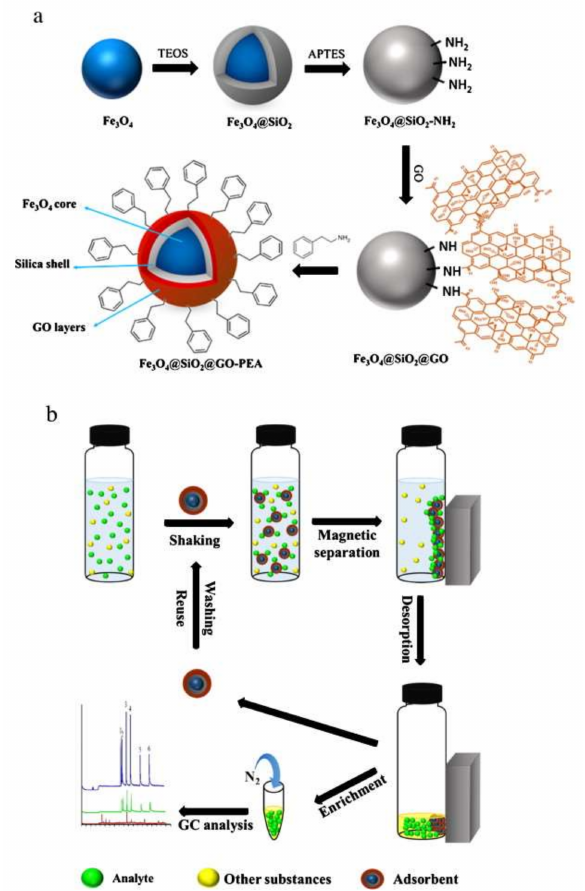
Figure 4. Synthesis of phenylethyl amine functionalized GO / Fe 3 O 4 ( a ) and its application on the MSPE procedure ( b ). Reproduced with permission from [91]. Copyright Elsevier,